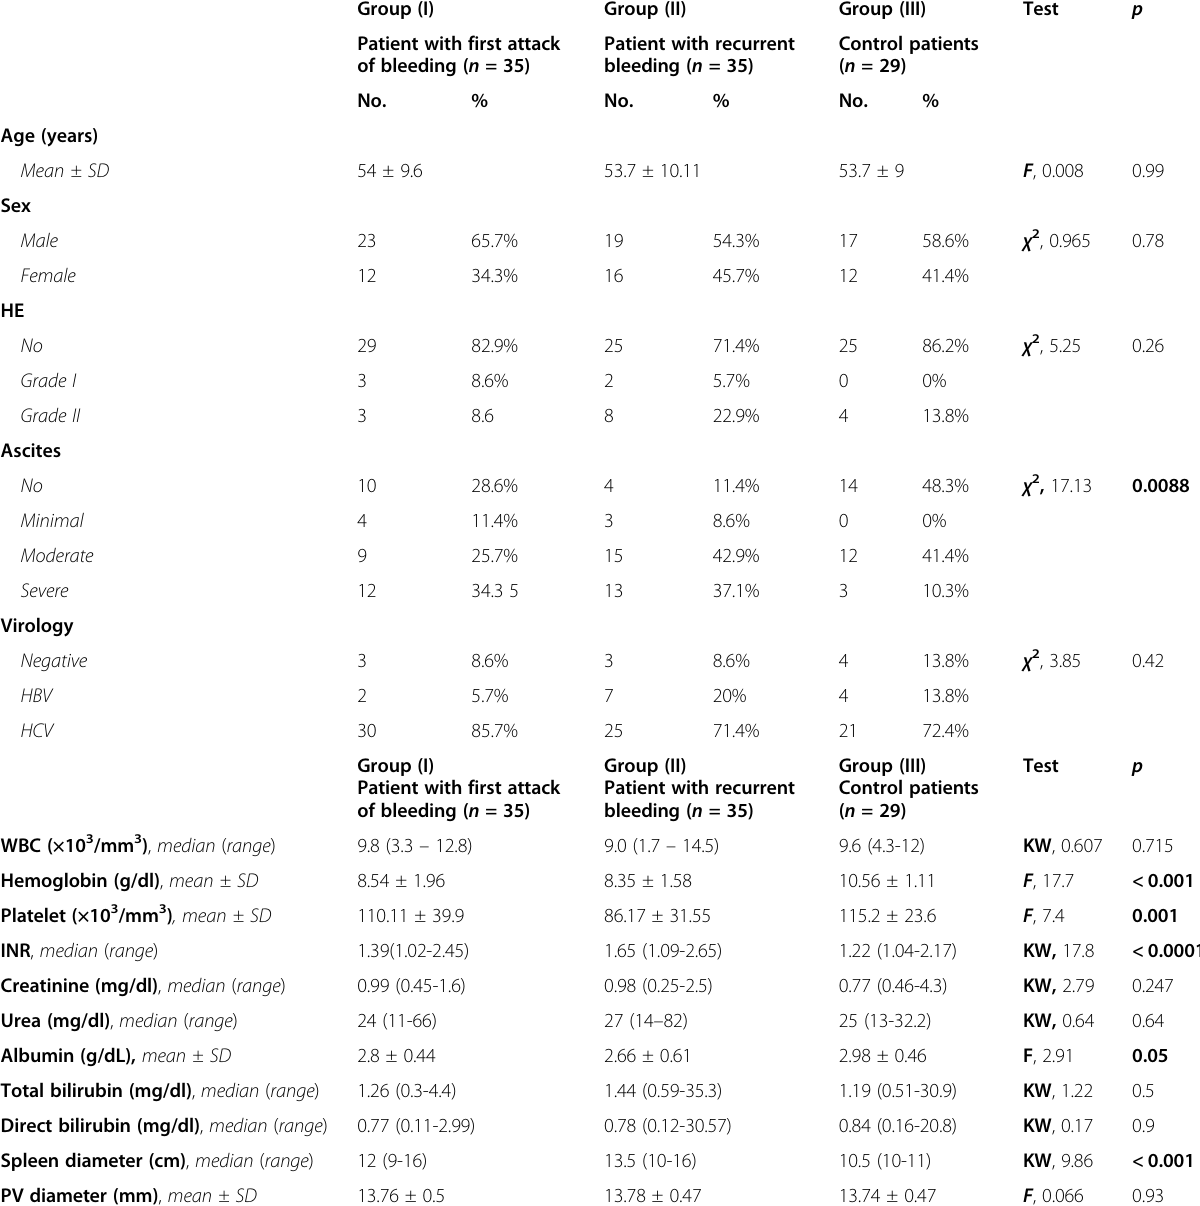
Table 1 Demographic and baseline characteristics of the study groups ( n = 99) Group